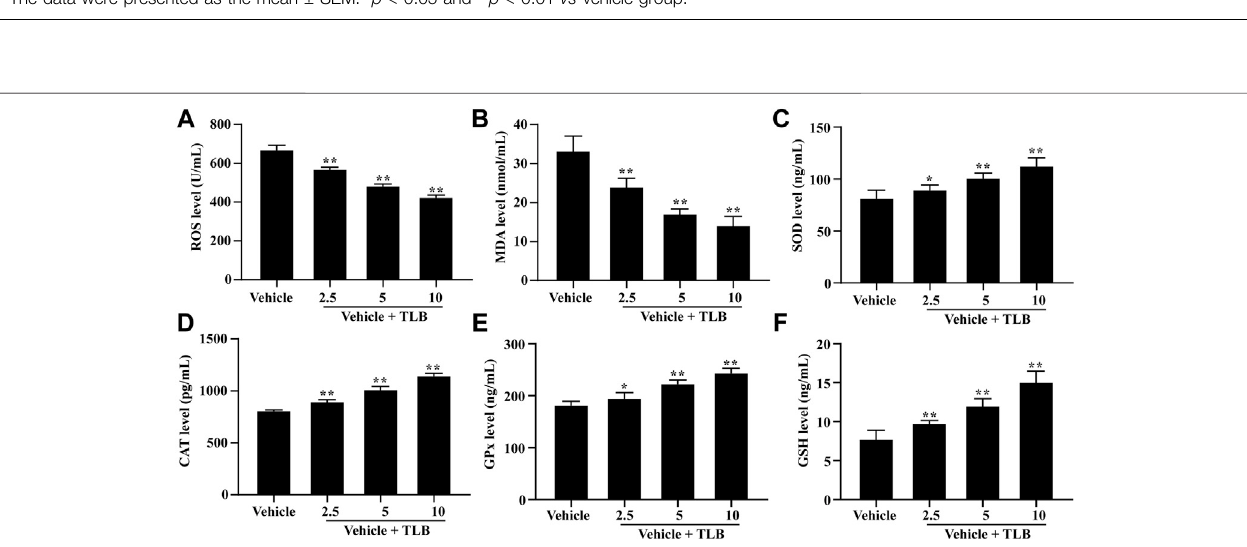
FIGURE 3 | Effect of TLB on oxidative stress in heart of fatigue mice. (A) ROS level, (B) MDA level, (C) CAT activity, (D) SOD activity, (E) GPx activity, and (F) GSH level. The data were presented as the mean ± SEM ( n = 10). * p < 0.05 and ** p < 0.01 vs vehicle group.